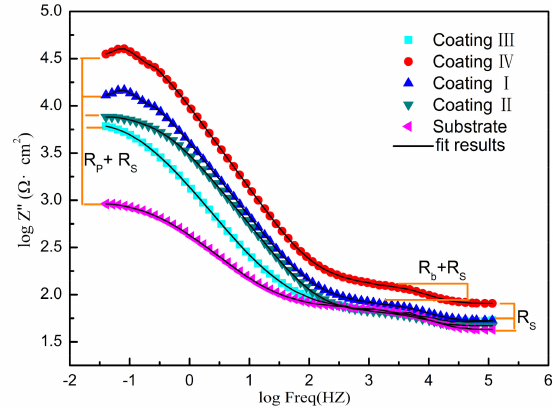
Figure 17. Bode plots of substrate and coatings with different powers.